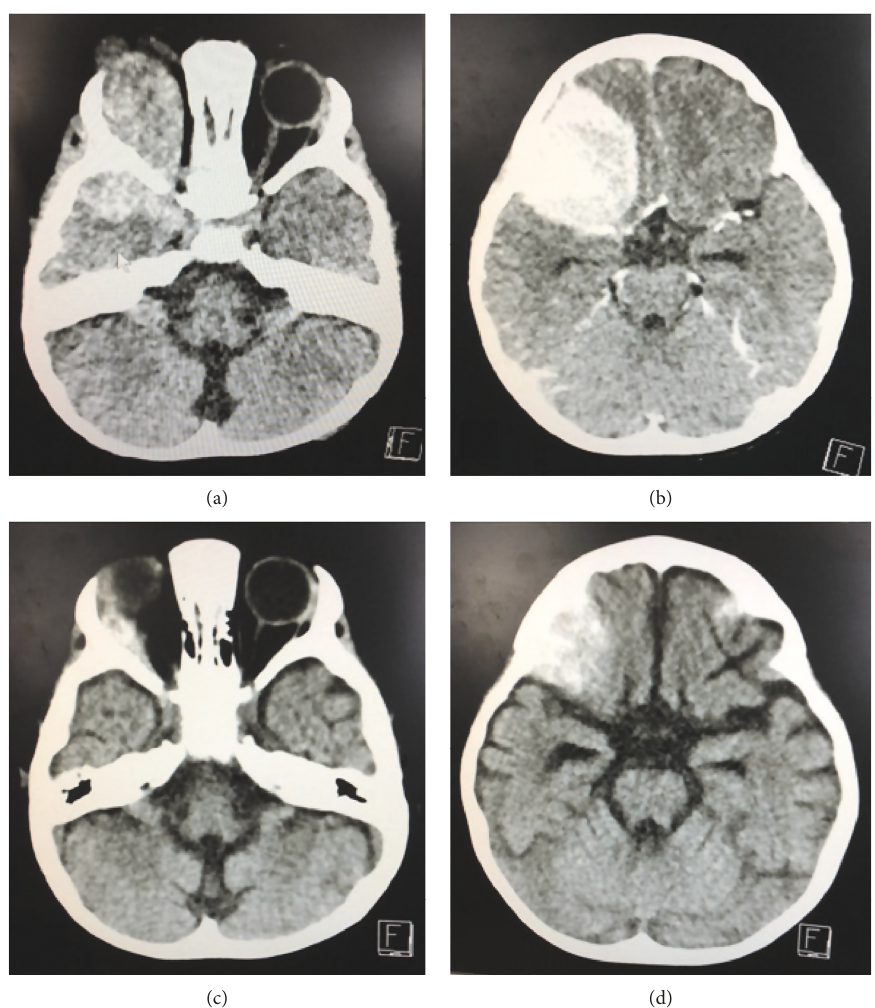
Figure 2: (a, b) Computed tomography scan revealed a homogeneous enhancing mass involving the right orbit with intracranial extension. (c, d) After 4 weeks of induction chemotherapy, decrease in the size of homogeneous enhancing mass involving the right orbit with intracranial